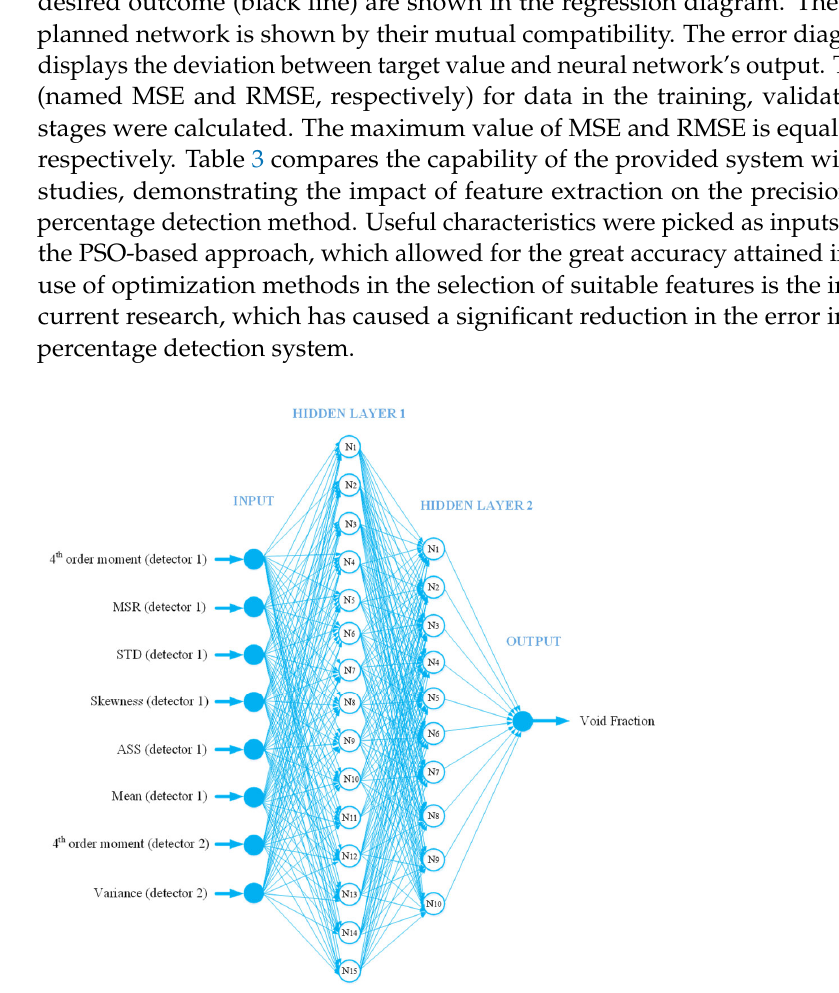
Figure 6. The neural network structure that was created to forecast the void fraction.